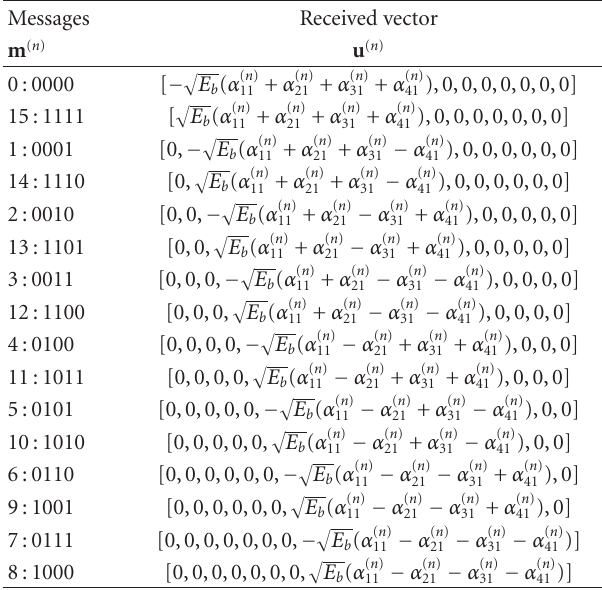
Table 2: The received vectors for the parity-bit-selected spreading technique for N t = 4 and N r =